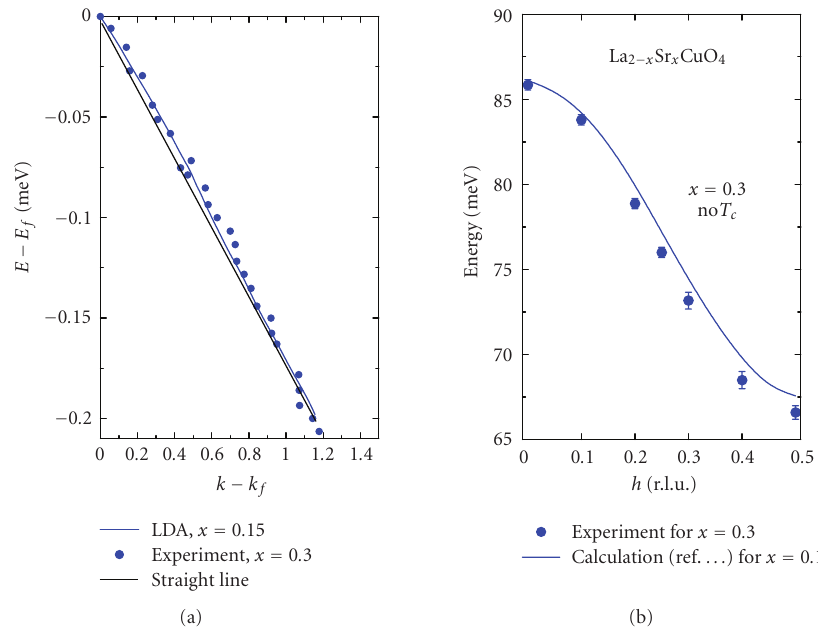
Figure 18: Comparison of the photoemission kink (a) and phonon dispersion (b) in La 1 . 7 Sr 0 . 3 CuO 4 with the DFT calculations for La 1 . 85 Sr 0 . 15 CuO 4 . (based on results of [30, 42, 82]). Black thin line in (a) is a straight line serving as a guide to the